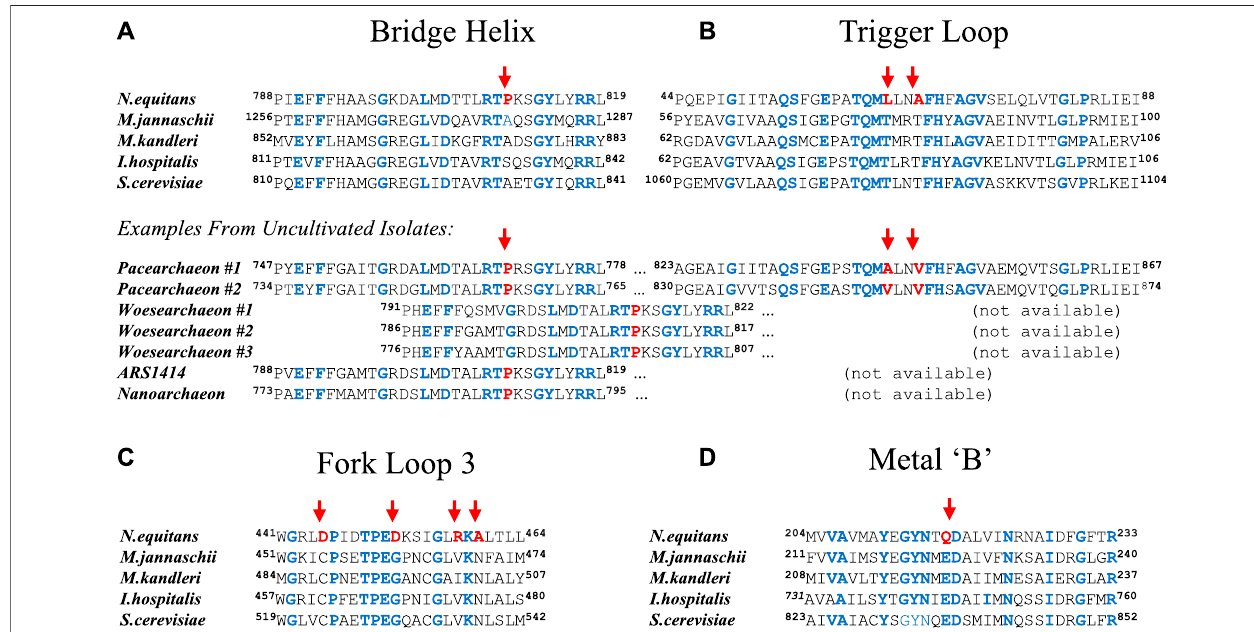
FIGURE 1 | Substitutions in key regions and domains of the nanoarchaeal RNAP catalytic site. Sequences from four archaeal ( Nanoarchaeum equitans , Methanocaldococcus jannaschii , Methanopyrus kandleri , and Ignicoccus hospitalis ) and one eukaryotic ( Saccharomyces cerevisiae ; RNA polymerase II) species are shown in all panels. Unusual substitutions in the nanoarchaeal sequence are highlighted with a red arrow. Residues identical in all sequences shown are highlighted in blue. The beginning and end positions of the sequences shown relative to the full length protein sequence are indicated as superscripts (A) Alignment of Bridge Helix sequences. N. equitans (SeqID: AAR39345.1), M. jannaschii (SeqID: WP_064,496,945.1), M. kandleri (SeqID: AAM01900.1), I. hospitalis (SeqID WP_011,998,279.1) and S. cerevisiae (SeqID: NP_010141.1). Below, additional examples from uncultivated and yet unnamed species are shown (